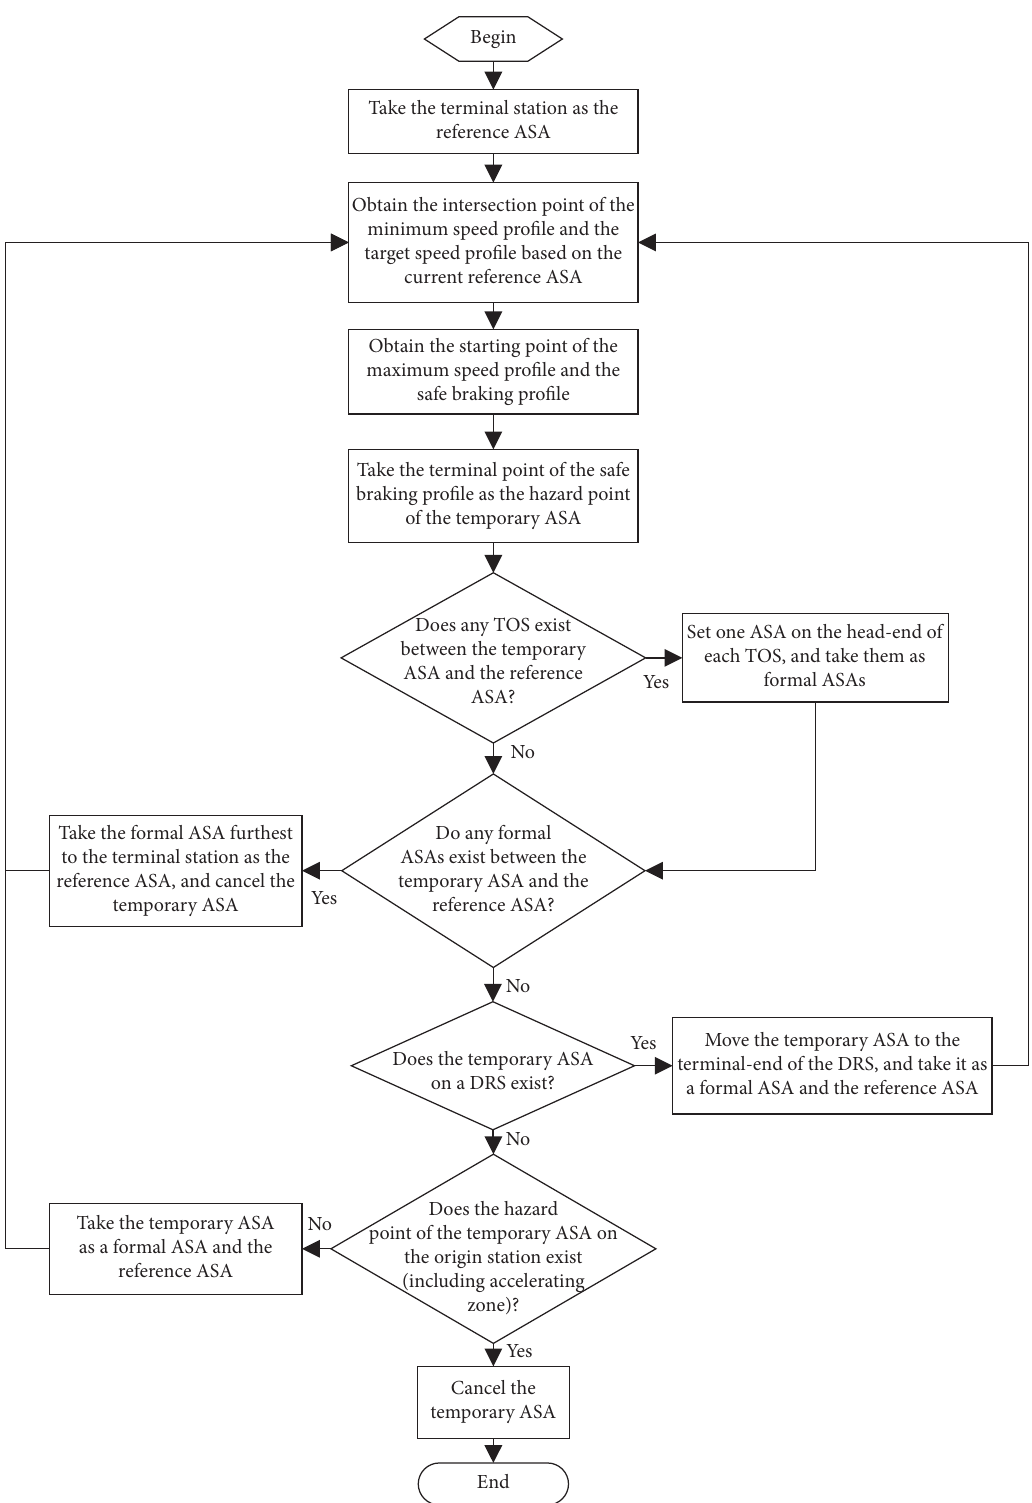
Figure 8: ASA layout starting from the terminal